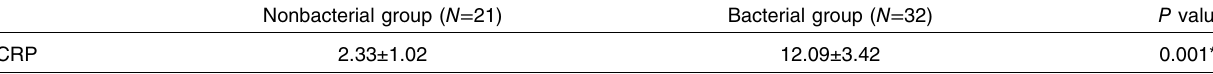
Table 19 Comparison between mean values of CRP in the bacterial and nonbacterial groups